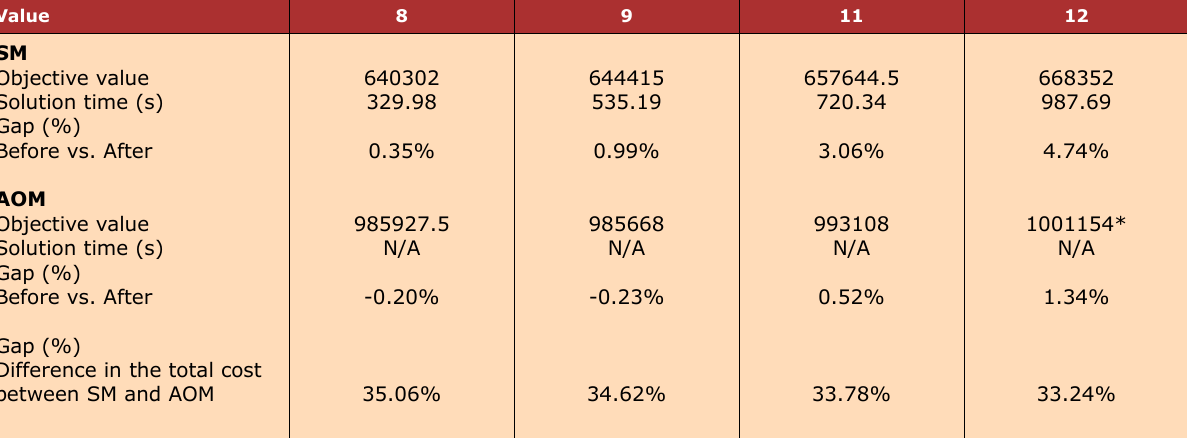
Table 3. Sensitivity analysis of the standard